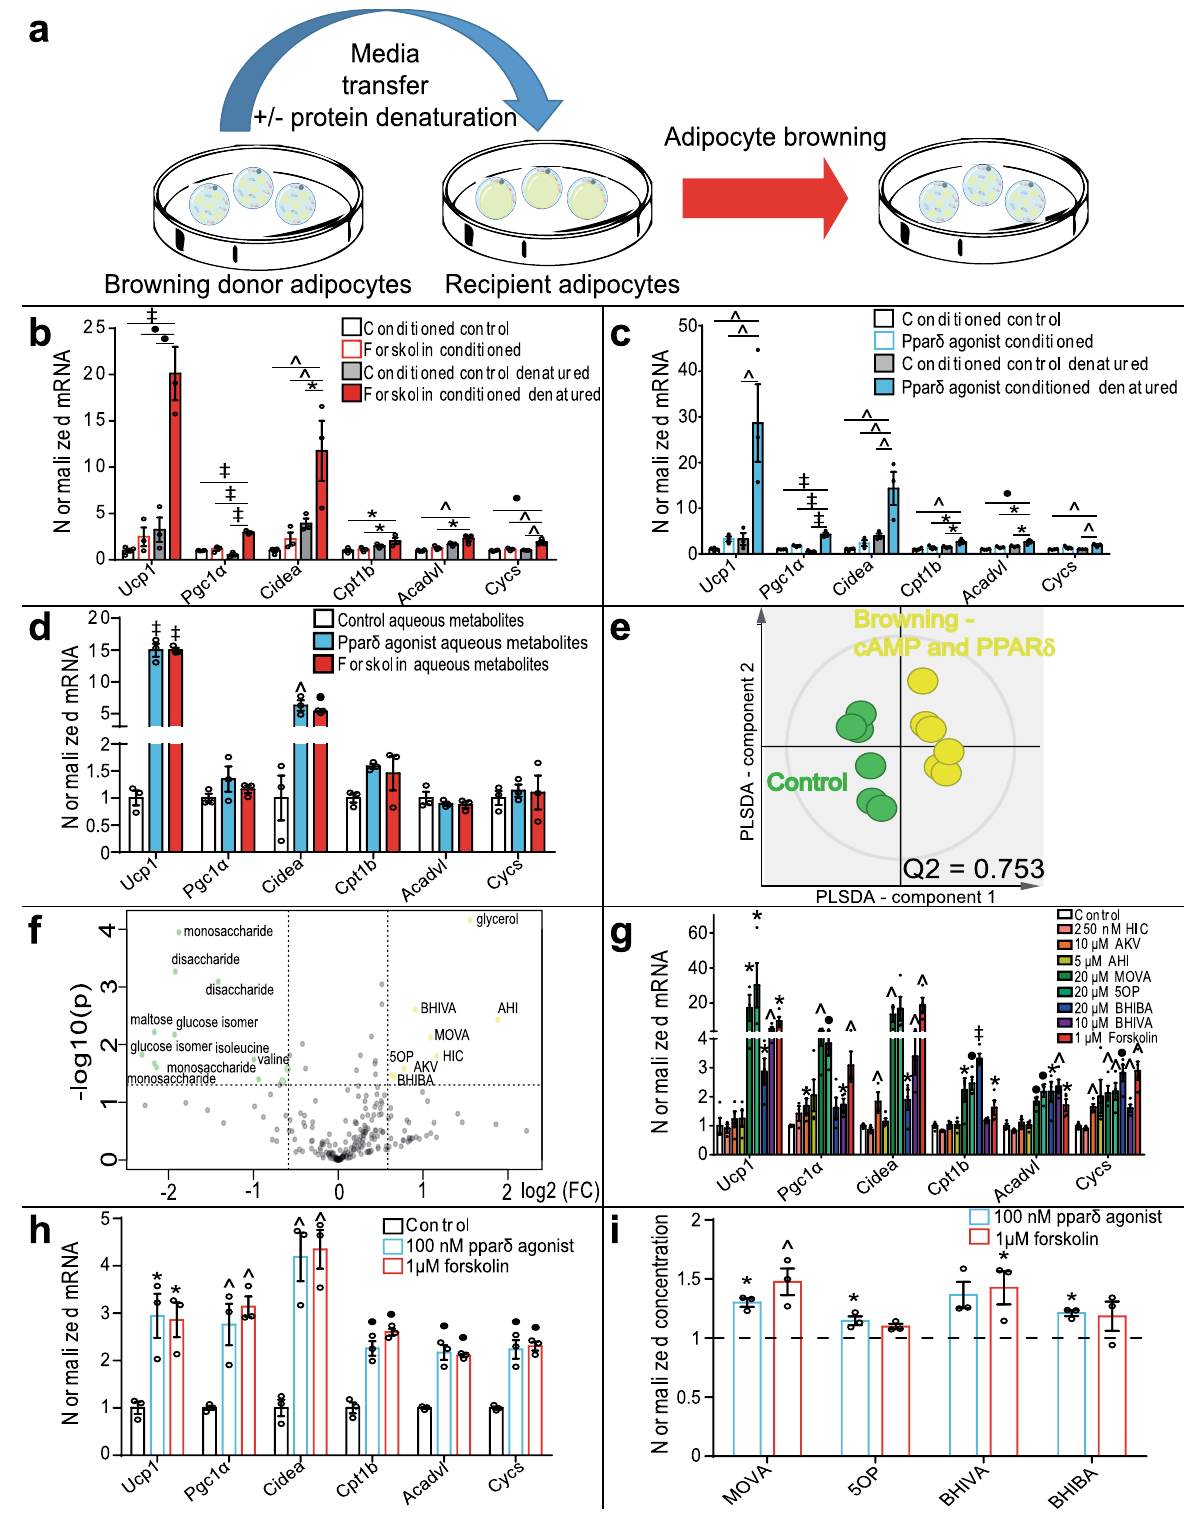
GC-MS analysis identi fi ed increased relative enrichment of downstream TCA cycle metabolites citrate, fumarate, and malate in MOVA, 5OP, and BHIBA-treated adipocytes (Fig. 2e – g), con fi rming that fatty acid β -oxidation is increased in these cells. The uptake of glucose and fatty acid into human primary adi- pocytes treated with the metabolites was measured with the fl uorescent glucose analog 6-NBDG or the fl uorescent fatty